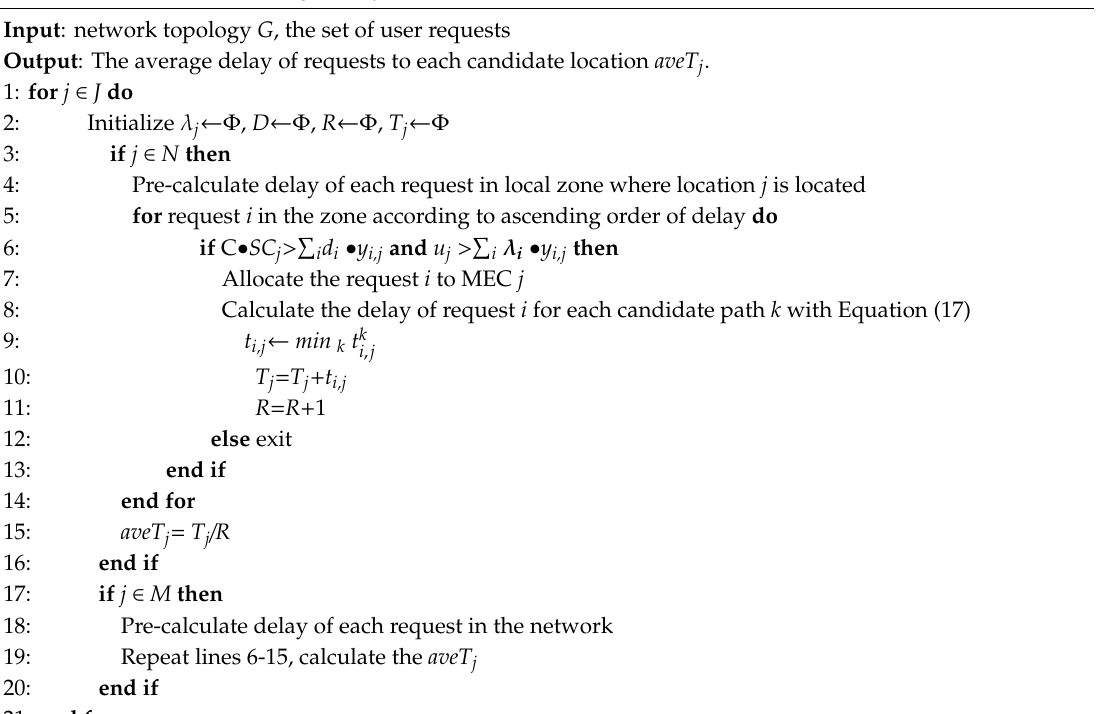
Algorithm 4: Calculate Average Delay for Each Candidate